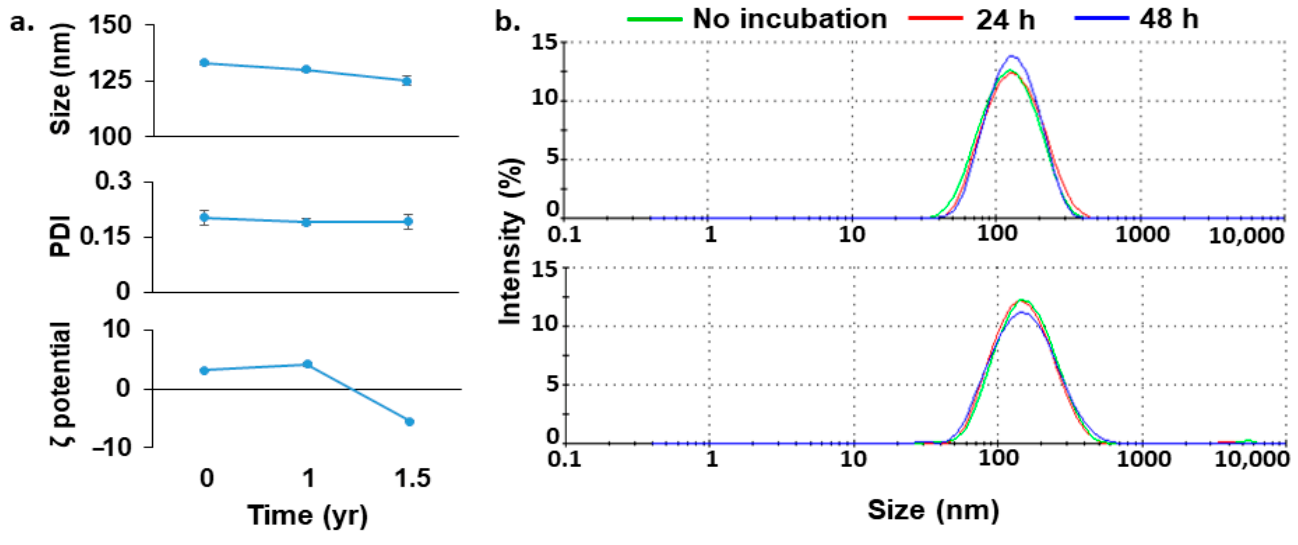
Figure 3. Stability and shelf-life of Lip DOPE -siHSV. ( a ) The long-term shelf-life stability of Lip DOPE - siHSV, suspended in TE buffer and stored at 4 °C, in terms of size, PDI, and surface charge changes. ( b ) The structural stability of Lip DOPE -siHSV (bottom) over time in comparison to empty liposomes (top) following incubation in 10% w / v bovine serum albumin at 37 °C. Gel electrophoresis studies revealed that siHSV extracted from liposomes remained intact, neither damaged by the preparation process nor following incubation in serum (Figure 4a). In addition, siHSV remained intact in keratinocytes (HaCaT) cell culture following internalization of the liposomal formulation in comparison to empty liposomes spiked with siHSV (Figure